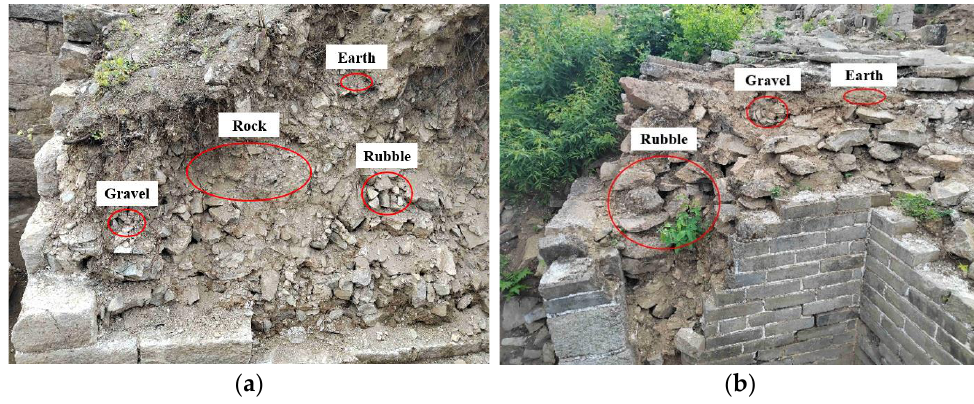
Figure 4. Pictures and components of the base wall’s interior side: ( a ) Watchtower; ( b ) Side wall.